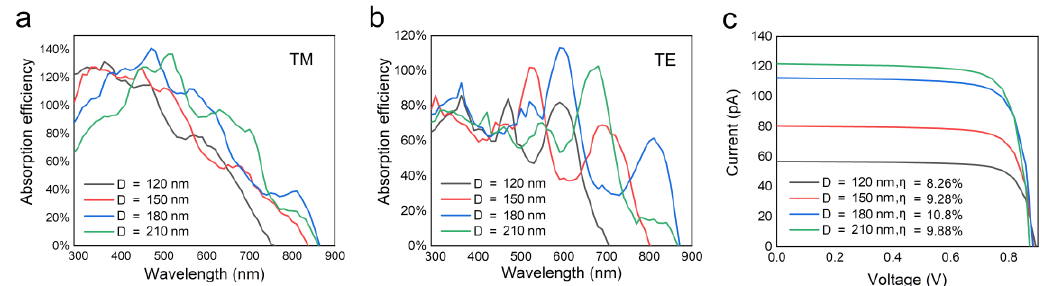
Figure 2. ( a , b ) The absorptance of the single horizontal nanowires (NWs) with di ff erent diameters for transverse-magnetic (TM) and transverse-electric (TE) polarized light, respectively. ( c ) The current–voltage characteristics of single horizontal NWs with di ff erent diameters.